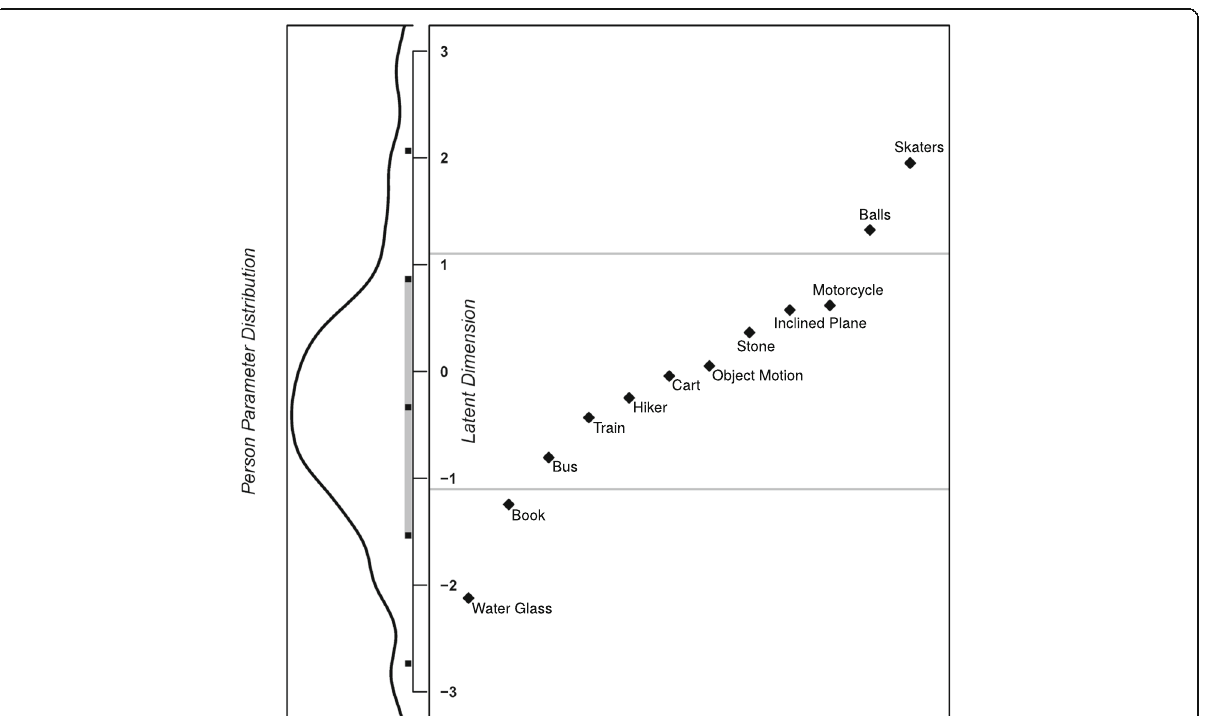
Fig. 4 Wright Map on the 12 items of the bMCU test and the N = 249 students. The left panel provides the distribution of the students ’ person parameters (ability), and the right panel depicts the location of each item ’ s difficulty parameter along the same latent dimension. From bottom to top, person ability and item difficulty increase. The gray bar on the latent dimension axis in the left panel indicates the range of values where approximately 68% of all person parameters are located. The black square in the middle of the bar marks the mean of all person parameters, the black squares at the upper and lower end of the bar correspond to the mean plus and minus one standard deviation. The two more extreme black squares on the latent dimension axis correspond to the mean plus and minus two standard deviations. Approximately 95% of all person parameters are located between these two squares. The two horizontal lines in the right panel correspond to the mean of the item parameters (i.e., M = 0) plus and minus one standard deviation, indicating the range of values where approximately 68% of all item parameters are located. The map shows that the items are reasonably spread across the students ’ ability range, with most items covering the average ability range, in which most students are